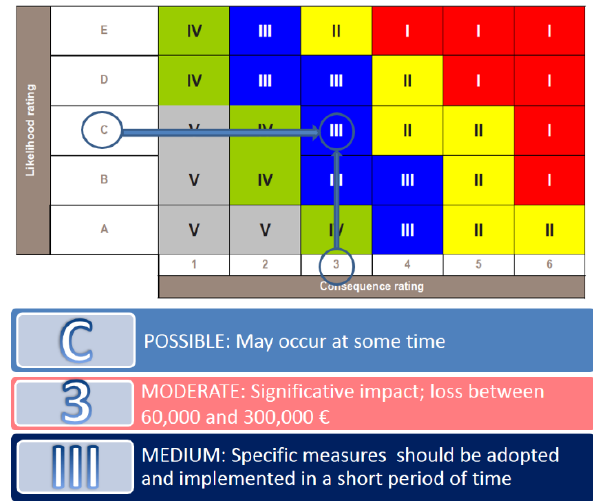
Figure 9. Risk analysis for modification of flows.